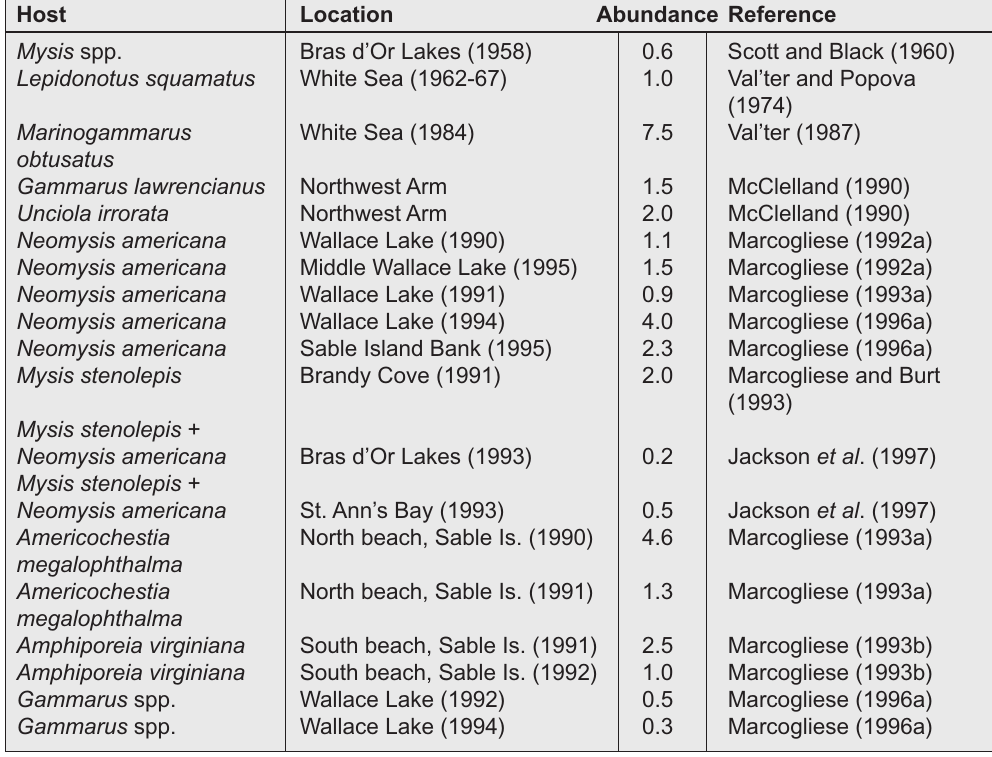
Table 3 . Mean abundance of sealworm ( Pseudoterranova decipiens ) reported in quantitative surveys of invertebrates (expressed as number of sealworms per 1000